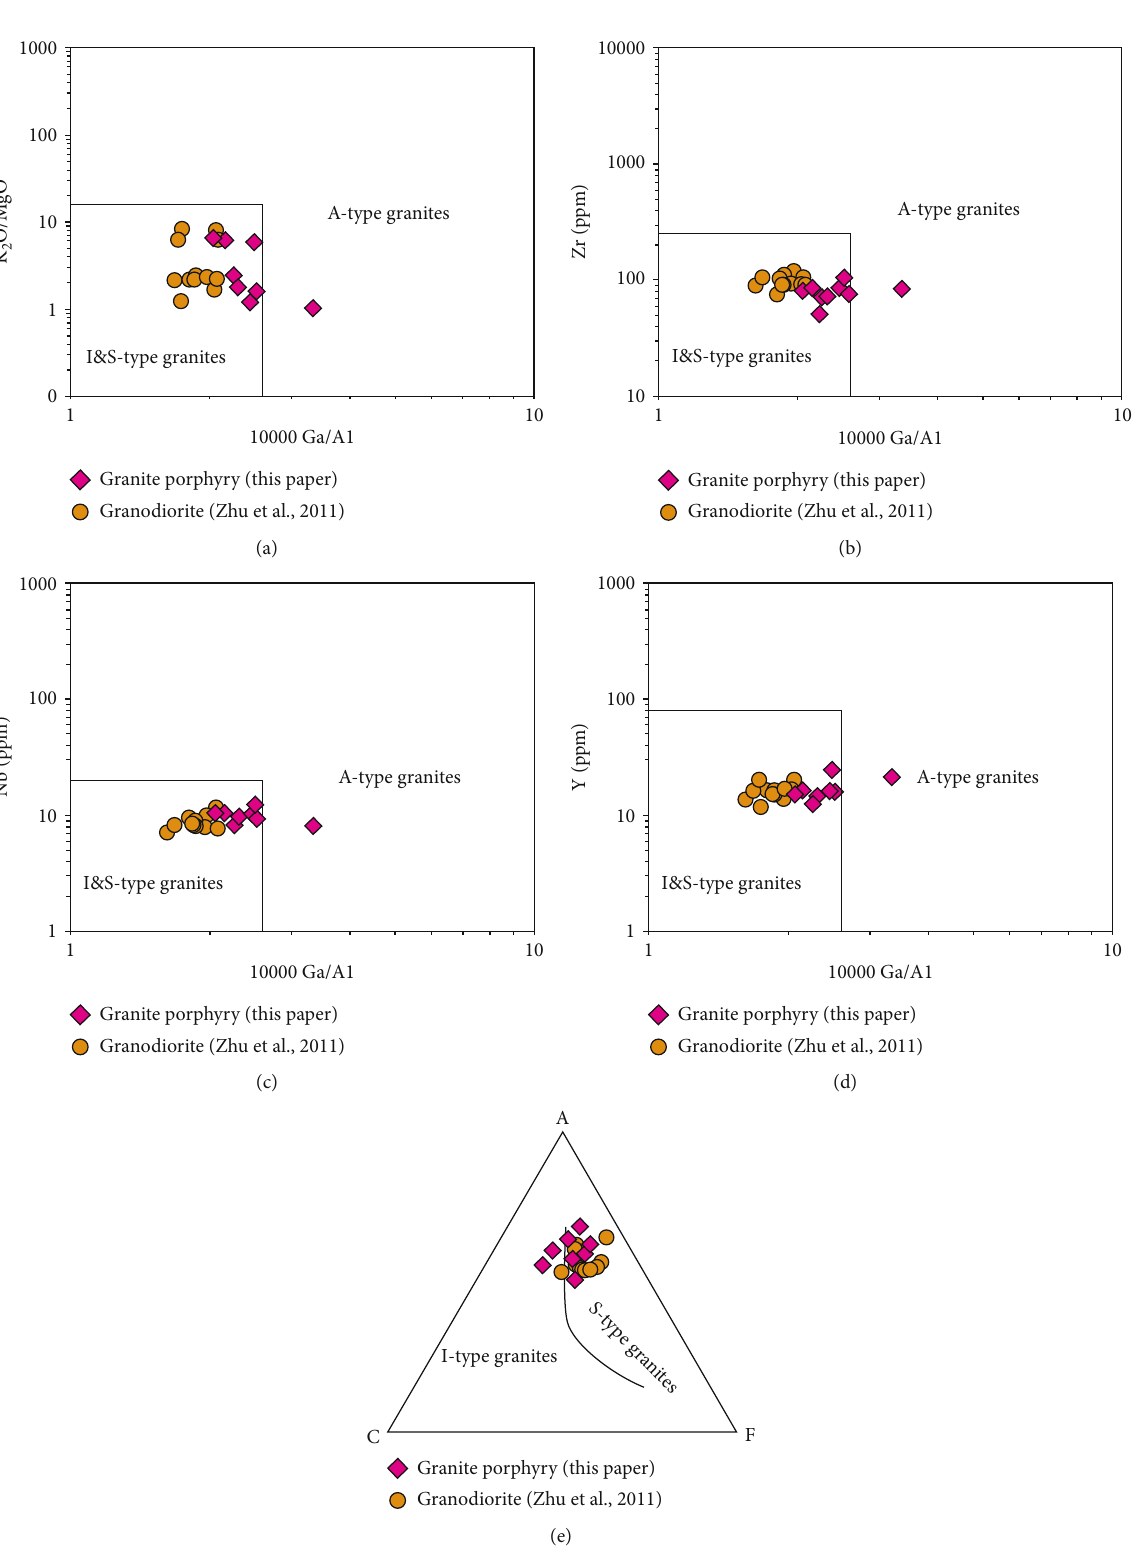
O/MgO) and trace elements (Zr, Nb, and Y) vs. 10000Ga/Al of the granite porphyries and granodiorite 2